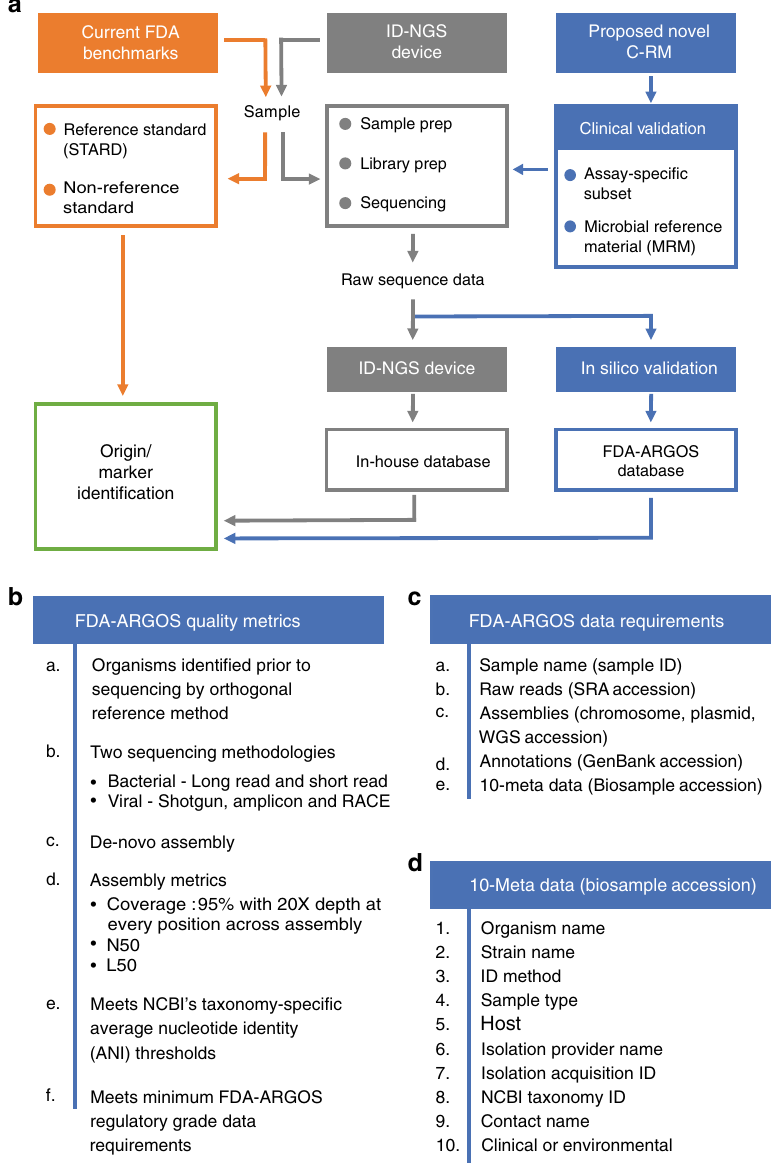
Figure 1c outlined these criteria including: sample name,